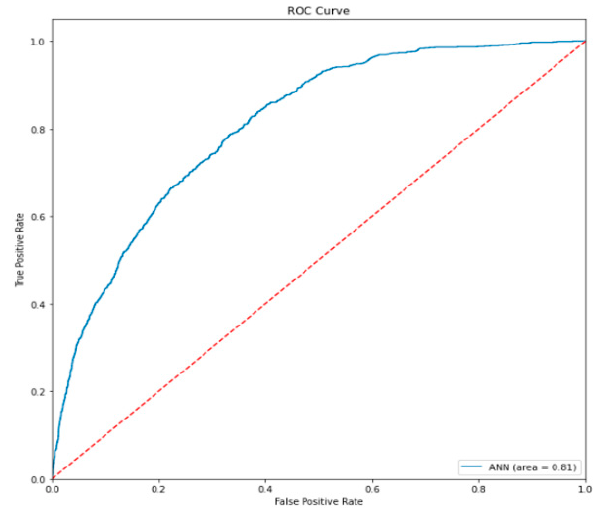
Figure 14. ROC and AUC curve.